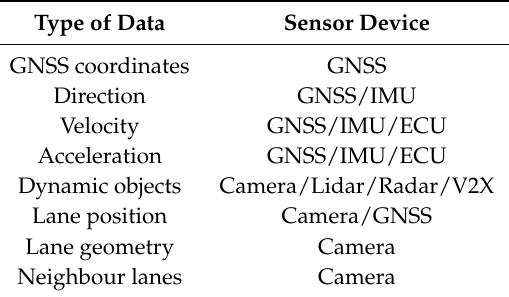
Table 2. Data types and used sensor devices, where GNSS is the Global Navigation Satellite System, and IMU is the Inertial Measurement